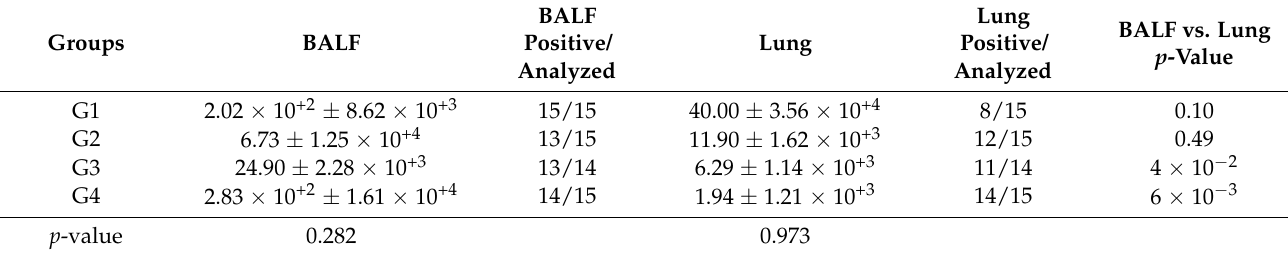
Figure 5. Boxplot with Mhyo quantification values in tracheobronchial and lung lavage samples for groups from G1 to G4 ( a , b ). The light dots represent each observation. The bold dots, centered on the boxplot, indicate the outliers. Table 4. Median ± median standard error of p102 gene detection and quantification values expressed in copies/ µ L and proportion of positive animals in analyzes of tracheobronchial and lung lavage samples by qPCR for groups from G1 to